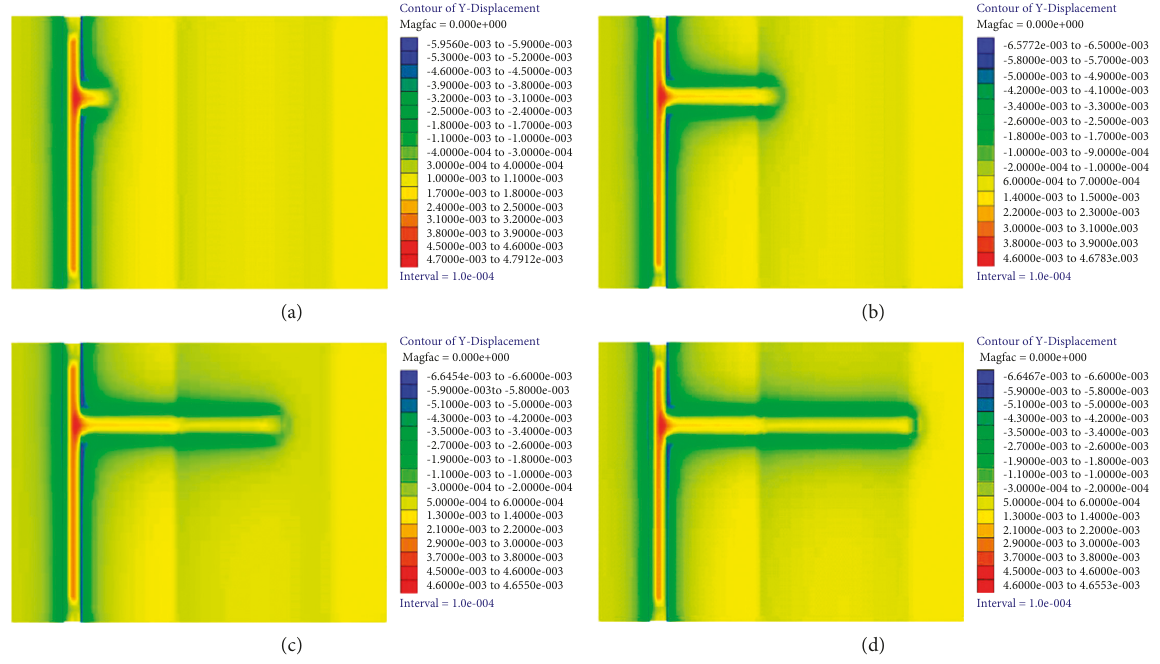
Figure 4: Displacement fields of the lateral tunnel. (a) Excavation 5m. (b) Excavation 20m. (c) Excavation 35m. (d) Excavation 45m.